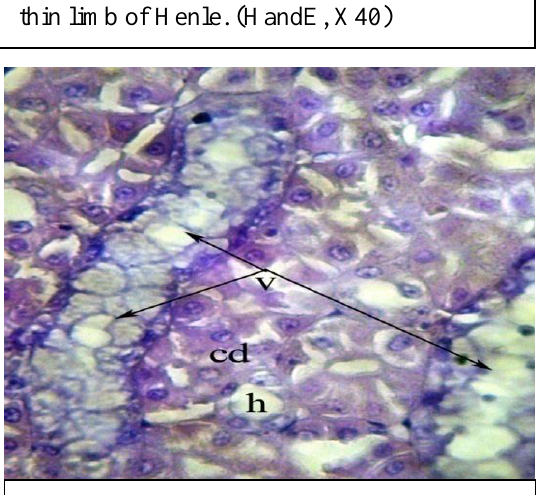
Fig.12: photomicroscope illustrate v. vacuoles in side cd. collecting ducts and Henles appeared (PAS) negative.(X40)